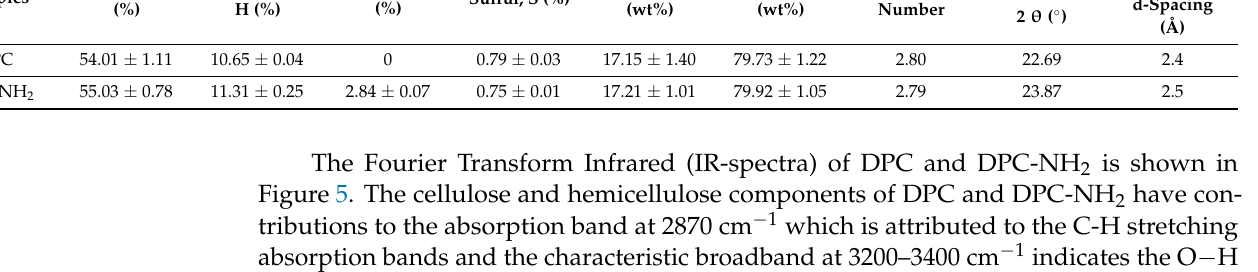
Figure 4. SEM image of ( a ) the top surface of the porous support and ( b ) the cross-section of dense top and porous support of composite membrane.